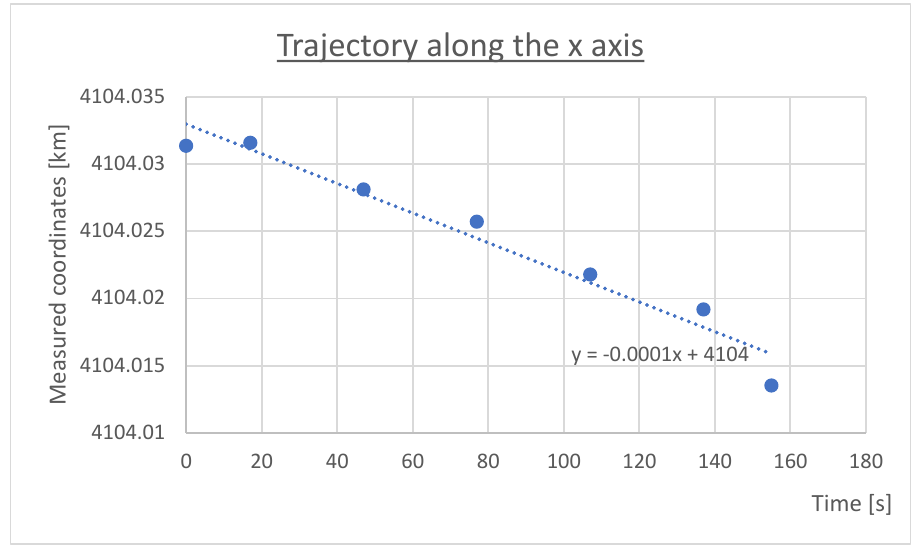
Figure 4. Geographical coordinates conversion, y axis.